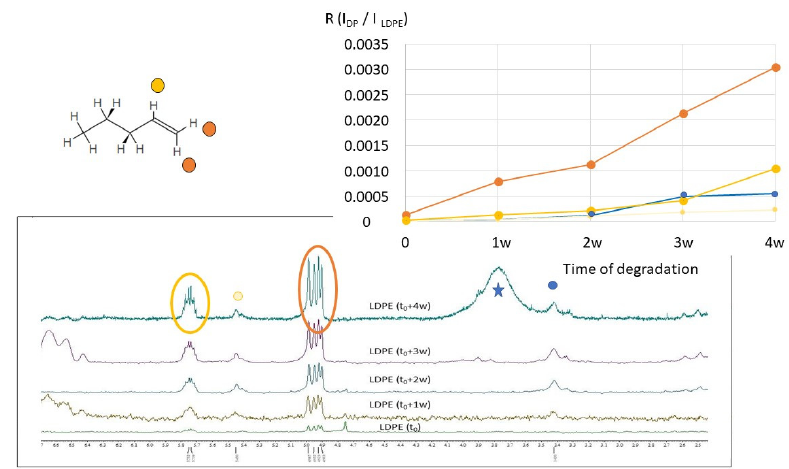
Figure 11. 1 H NMR spectra of the LDPE in the region between 2.4 ppm and 6.7 ppm. Signals ascribable to 1-alkene (such as 1-pentene, see the molecular sketch on the top) are marked with colored circles. Trends of the ratio R between the integral of the CH 2 - signals of LDPE (I LDPE ) and the integral of the signals of degradation products (I DP ), during the degradation time, from 0 (t 0 ) to 4 weeks (t 0 + 4 w), are reported on the right. Four most significant signals have been selected, ascribable to alkene and alcohol compounds. The large signals in the spectrum at t 0 + 4 w (marked with a star) are due to water.